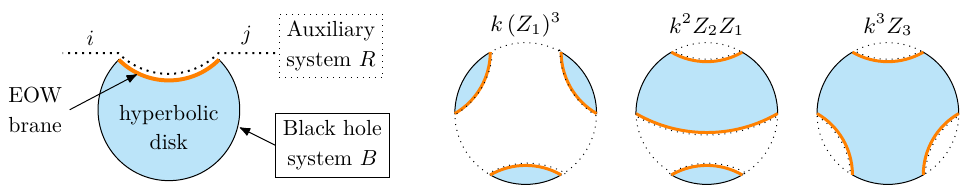
Figure 2 . [Left] The geometry of h ψ i | ψ j i B in the EOW brane model. The hyperbolic disk (blue) has the asymptotic boundary and terminates on the EOW brane (orange). [Right] The replica geometries for the moment (2.3) of ρ R with n = 3 . There are three ways to connect the EOW branes in the bulk region. The planar replica wormholes with l -dotted loops and m b -disconnected disk regions with b -asymptotic boundaries provide the factors k l Q ( Z b ) m b respectively. m b ,b where Z is a partition function for a replica wormhole connecting n -copies of the auxiliary n system R . Since the wormhole has disk topology, Z ∝ e S 0 and then the moment is a finite n series of α . The n th term ∝ α n − 1 0